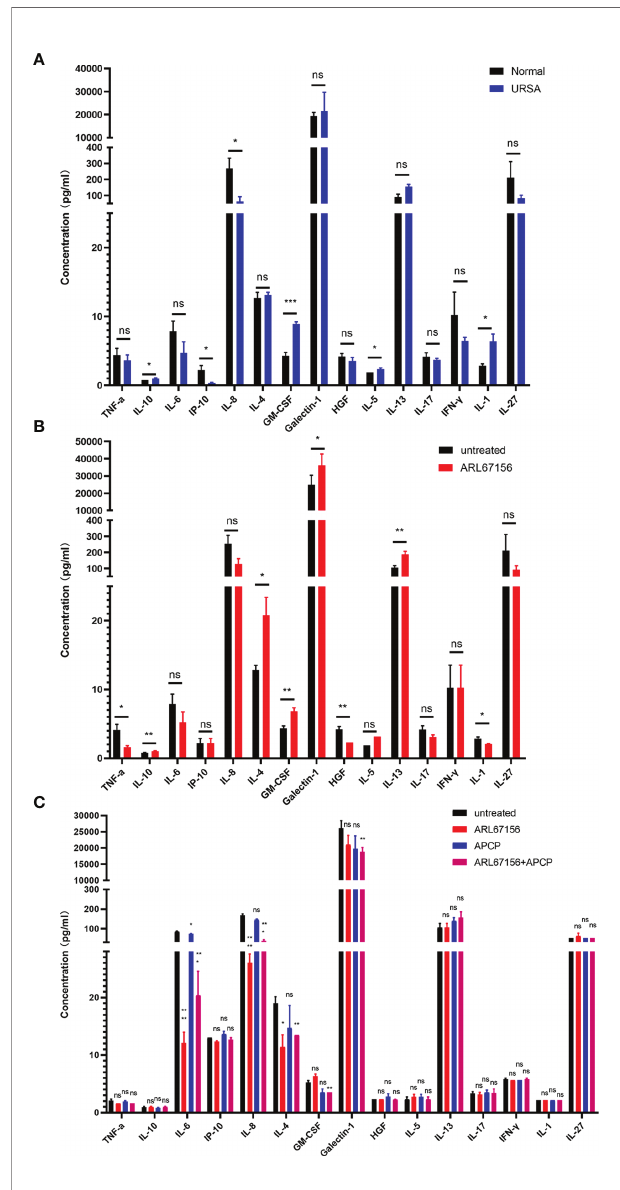
FIGURE 4 | The effect of CD39/CD73 inhibiting on the cytokine secretionofdNK cells. (A) dNKcellswere isolated from decidual tissues of normal pregnant women (n=4) and URSA patients (n=4), and cultured in a 24-well plate (2 × 10 5 cells/well) for 24 hours. The cytokine concentrations in the media were determinedusing Luminex assay(mean ± SEM, ns, statistically not signi fi cant, *P < 0.05, ***P < 0.001, two-tailed t tests). (B) Cytokine concentrations inthe media of dNK cells (n=5) cultured in the absence or presence of the CD39 inhibitor ARL67156 in 24- well plates for 24 hours (mean ± SEM, ns, statisticallynot signi fi cant, *P < 0.05, **P < 0.01, two-tailed t tests). (C) Cytokine concentrations in the media at 24 hours of co-culture of dNK and HTR-8/SVneo cells (n=3) (mean± SEM, ns, statistically not signi fi cant, *P < 0.05, **P < 0.01, ***P < 0.001, ****P < 0.0001 comparedwith the untreatedgroup, one-way ANOVA and post hoc